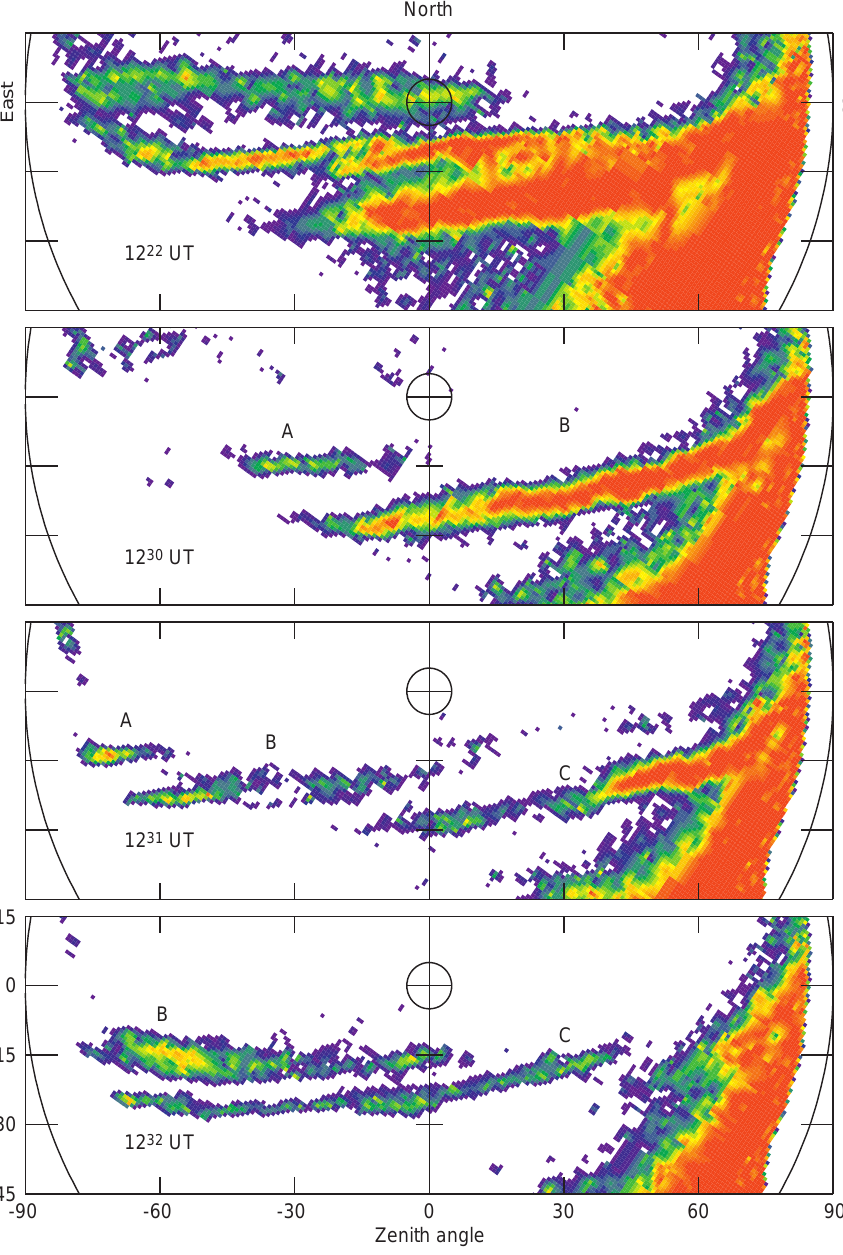
Fig. 9. Four white light Longyearbyen ASC images from wave packet IV, on an arbitary intensity scale. The images have been rotated such that geomagnetic north is directed towards the top of each panel. The last three images form a time series with 60 s time step; the letters A to C indicate the probable relationship between the auroral features in